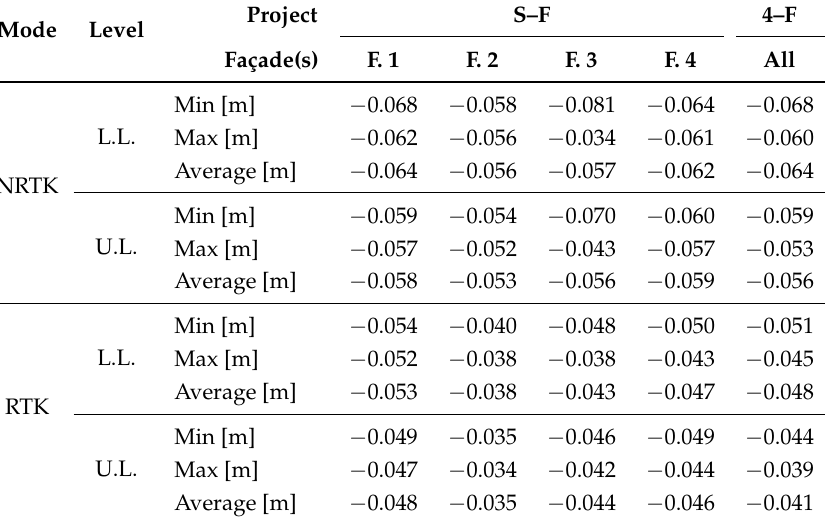
Table 6. Vertical